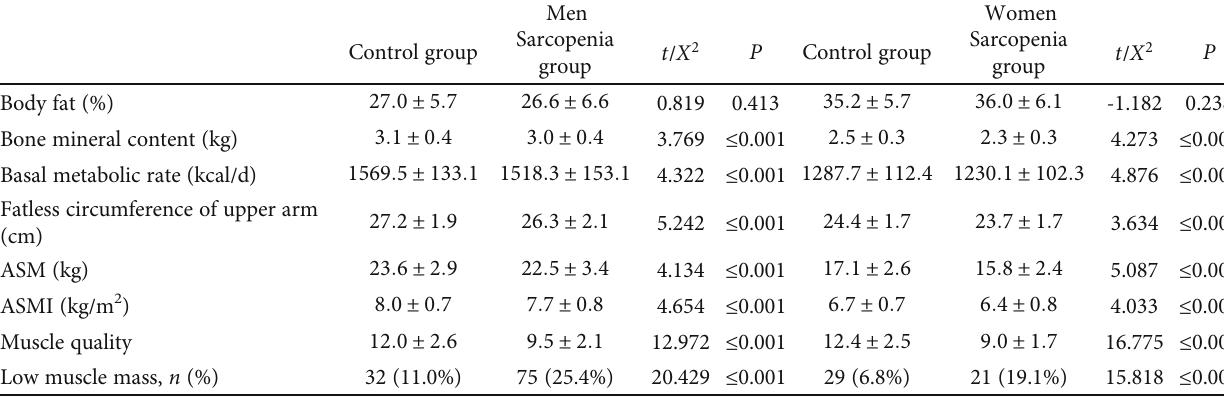
Table 4: Body composition in T2DM participants in the sarcopenia group and control group strati fi ed by sex.